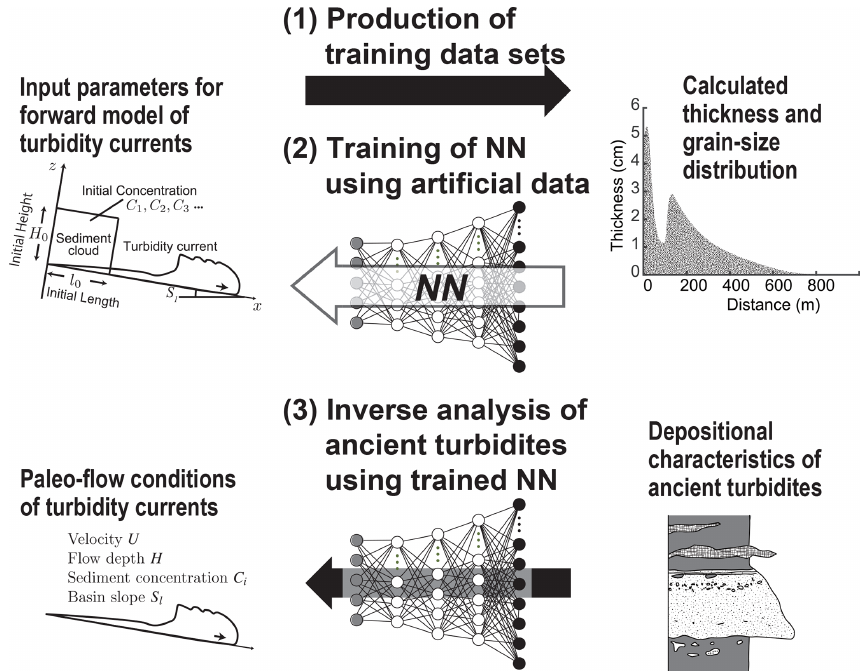
Figure 1. Schematic diagram of the inversion process of turbidity currents from deposits. The method is composed of three steps: (1) gener- ation of training datasets by the forward model using random values for model input parameters, (2) training of the NN based on the artificial datasets, and (3) application of the trained inverse model to unknown field datasets.